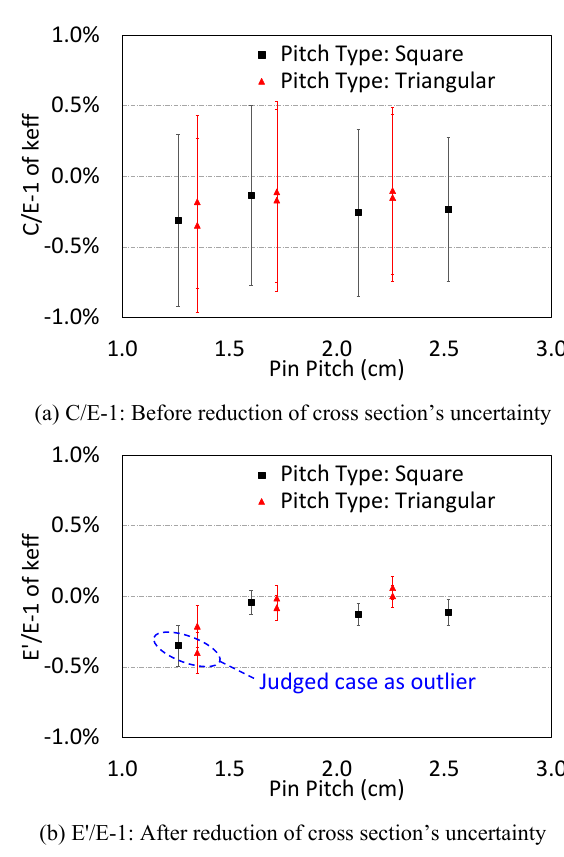
Fig. 5. C/E-1 and E'/E-1 of keff of LCT-007.